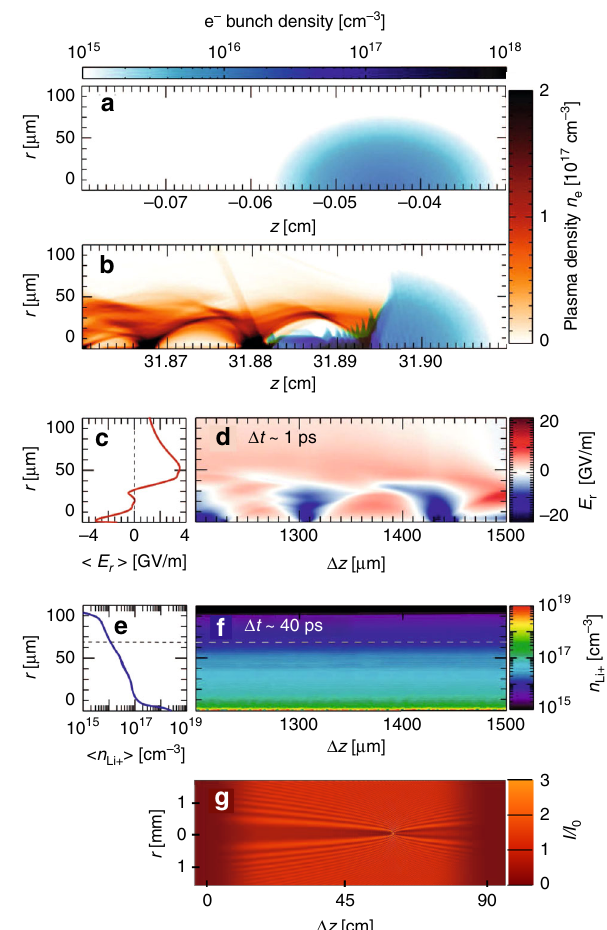
Fig. 3 OSIRIS simulation results. Drive bunch pro fi le at a z < 0 (blue), before entering Li vapor at z = 0, and at b z ≈ 32 cm, after entering the Li density plateau, focusing, and creating trailing beam-ionized plasma and electron wake (orange). c Fixed-window simulation of longitudinally averaged and d full radial electric fi eld E r ( r , z ) pro fi les at Δ t ~ 1 ps after the driver passes. The non-zero averaged fi eld [red curve in c ] attracts (repels) ions at r ≤ 30 μ m ( r > 30 μ m) to (from) the axis. e Longitudinally-averaged and f full ion density at Δ t ~ 40 ps after driver passage. Dashed line indicates the maximum r ≈ 65 μ m to which drive bunch directly ionized Li. g Calculated probe diffraction pattern from density pro fi le in e , cf. measured pattern for Δ t ~ 100 ps in Fig.